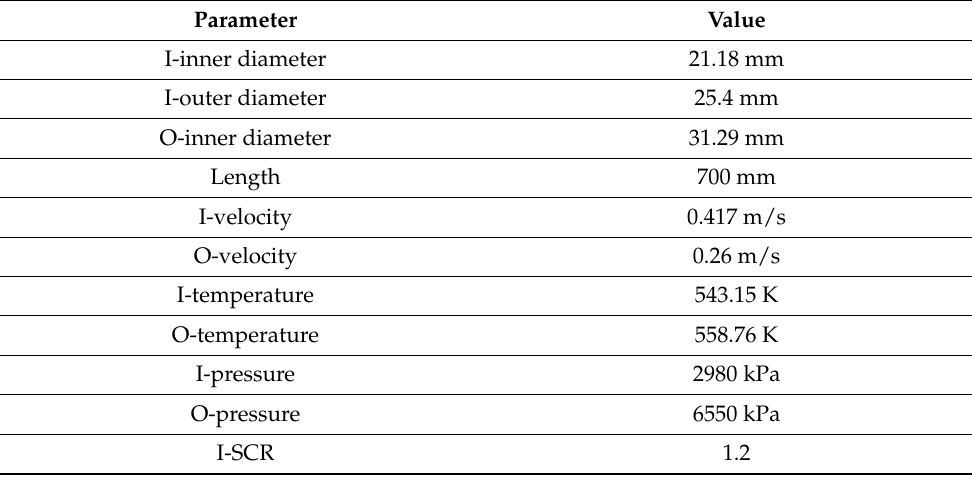
Table 1. Detailed parameters of the